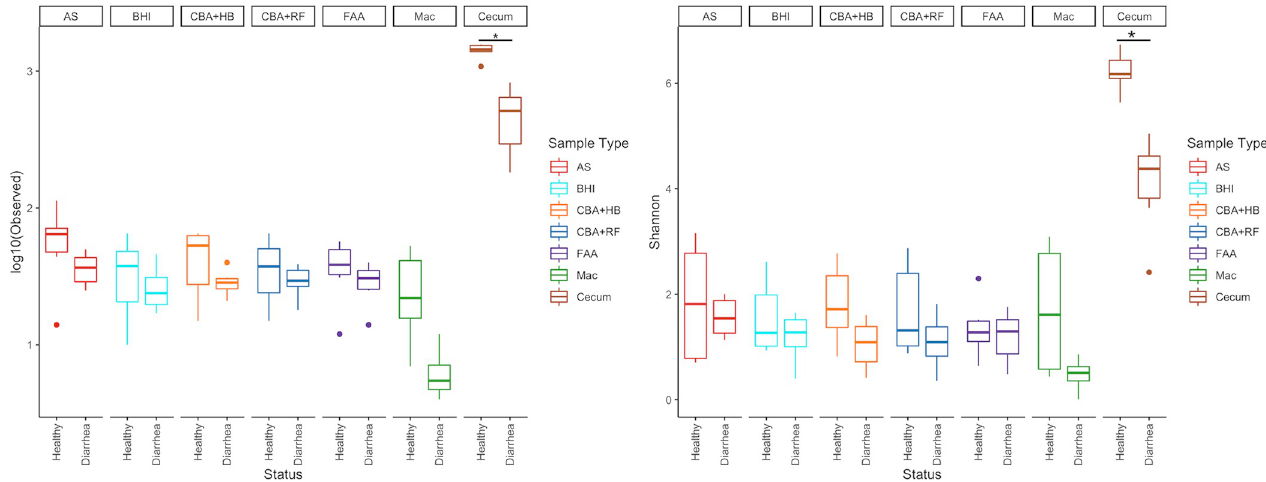
Fig 2. Observed and Shannon diversity of different media types divided by the groups of healthy horses and horses with diarrhea. Abbreviations: MacConkey agar (Mac), fastidious agar with horse’s blood added (FAA), Columbia agar with horse’s blood added (CBA+HB), Columbia agar with rumen fluid added (CBA+RF), BHI3 with carbohydrate added (BHI), AS (samples plated on CBA+HB after alcohol shock), and Cecum (samples sequenced directly, without culture). (Fig 3). The PCoA plot based on weighted UniFrac distances showed that cecum samples clus- tered separately from those that underwent alcohol shock, cultured aerobically on MacConkey agar, or cultured on BHI and FAA. Visually, the microbial composition of the MacConkey samples is substantially different from that of samples cultured under other conditions and media. Both sample type (i.e. type of culture or direct sequencing) and status (i.e., healthy or